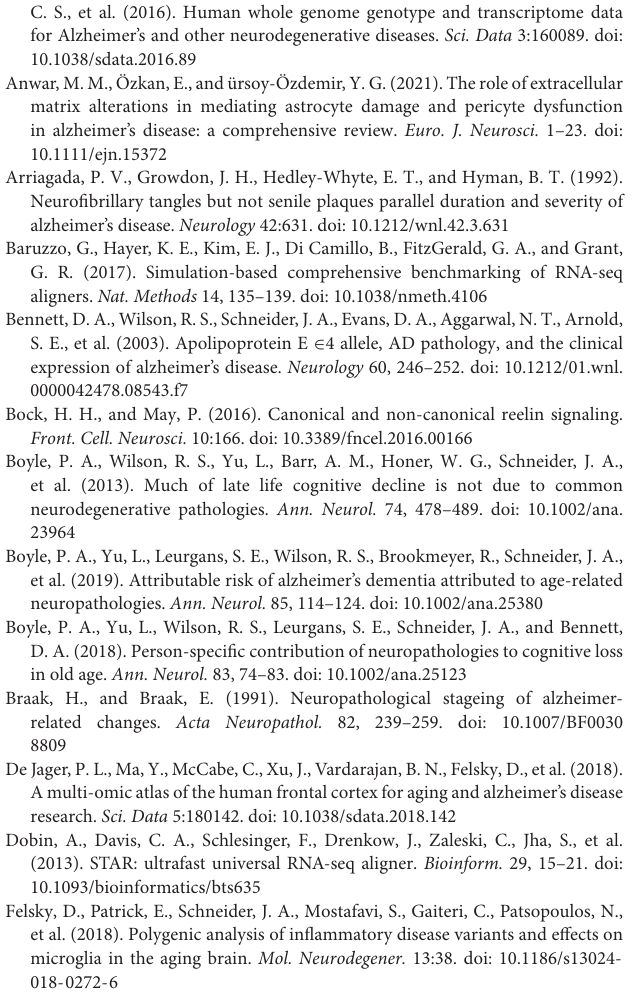
Supplementary Table 1 | Complete Boruta results from the RNA sequencing analyses. Supplementary Table 2 | Gene information and key functions of ADAMTS2 and PRTN3.